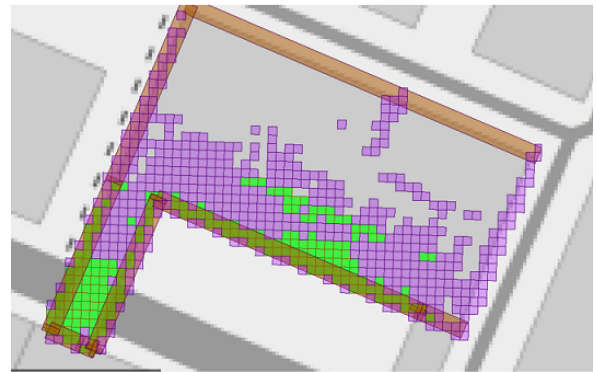
Figure 4. Coverage assessment of the walls of a building visualized from the top view: Qualified walls (brown), dense patches (green), and sparse patches (purple). The large glass fronts of the building resulted in substantial laser reflections inside the building footprint.